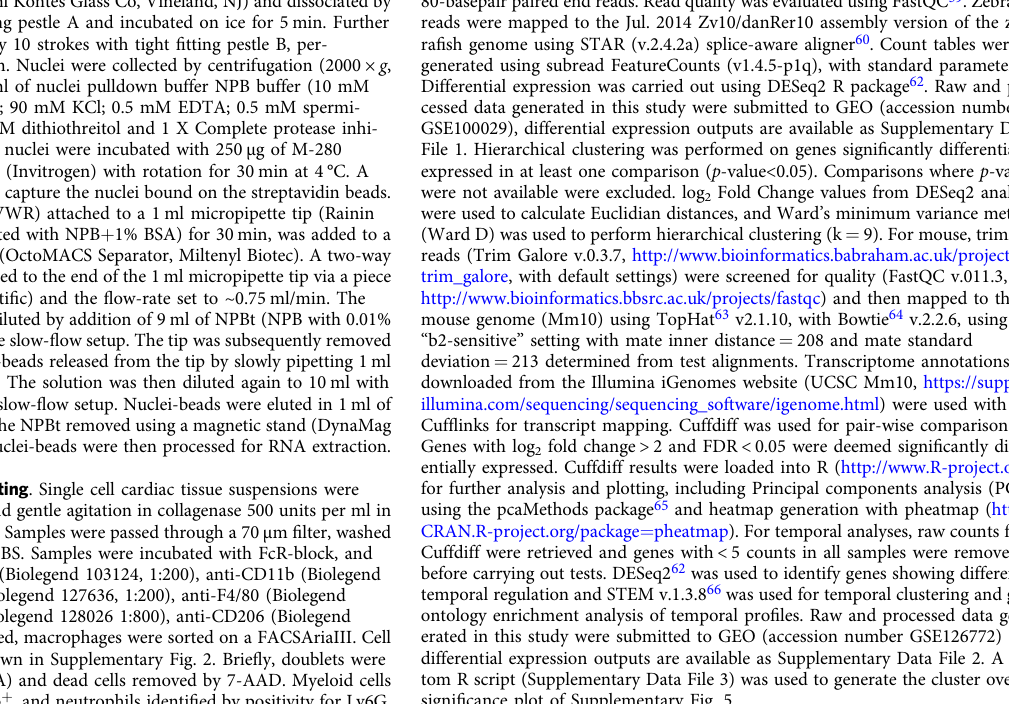
Fig. 5 Zebra fi sh macrophages directly contribute to transient scar formation by collagen synthesis. a Adoptive transfer of GFP + macrophages derived from a resection heart into a cryoinjured heart via retro-orbital (RO) injection. Wholemount heart showing transplanted macrophages in 7 days post injury (dpi) recipient hearts, hoechst-stained nuclei in grey. Scale bars: 200 μ m, high-magni fi cation 100 μ m. b – g Masson ’ s trichrome staining of Hanks-injected ( b ; high-magni fi cation in c ), neural crest cells (NCC)-transplanted ( d ; high-magni fi cation in e ), and macrophages-transplanted ( f ; high-magni fi cation in g ) hearts showing pericardiac fi brosis (blue, arrowheads) around the cryoinjured area (pink, black asterisk). Scale bars: 200 μ m, high-magni fi cation: 50 μ m. h Quanti fi cation of scar fi brosis (percentage of total section area, 6 sections per heart: hanks-injected 4.611 ± 1.26%, n = 4 vs macrophage-transplanted 14.87 ± 0.81%, n = 6; *** p < 0.0001; NCC-transplanted 4.53 ± 0.643%, n = 6 vs macrophage-transplanted 14.87 ± 0.81%, n = 6; *** p < 0.0001; hanks- injected 4.611 ± 1.26%, n = 4 vs NCC-transplanted 4.53 ± 0.643%, n = 6; p = 0.951, ns, not signi fi cant). 2-tailed, unpaired Student ’ s t -test, data are mean ± SEM. i “ Trio ” tagging approach: Cas9 protein, guide RNAs and genetrap construct coding for Citrine, are injected in 1-cell stage embryos. Double-strand breaks are generated in the col4a1 intron and the donor construct, resulting in integration of Citrine ORF fl anked by splice acceptor (SA) and donor